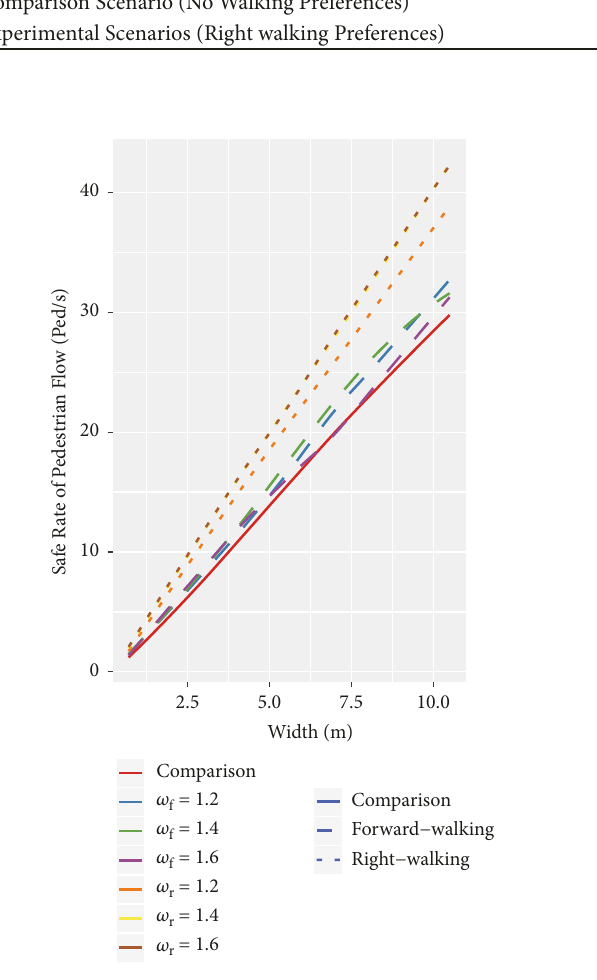
Figure 16: Safe rate of pedestrian flow with variances in tunnel width and walking